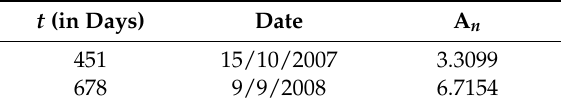
Table 18. Change points in the estimated bivariate jump time series of Microsoft with the corresponding Table 19. Change points for the estimated positive jumps of Microsoft with the corresponding test test statistic statistic value.